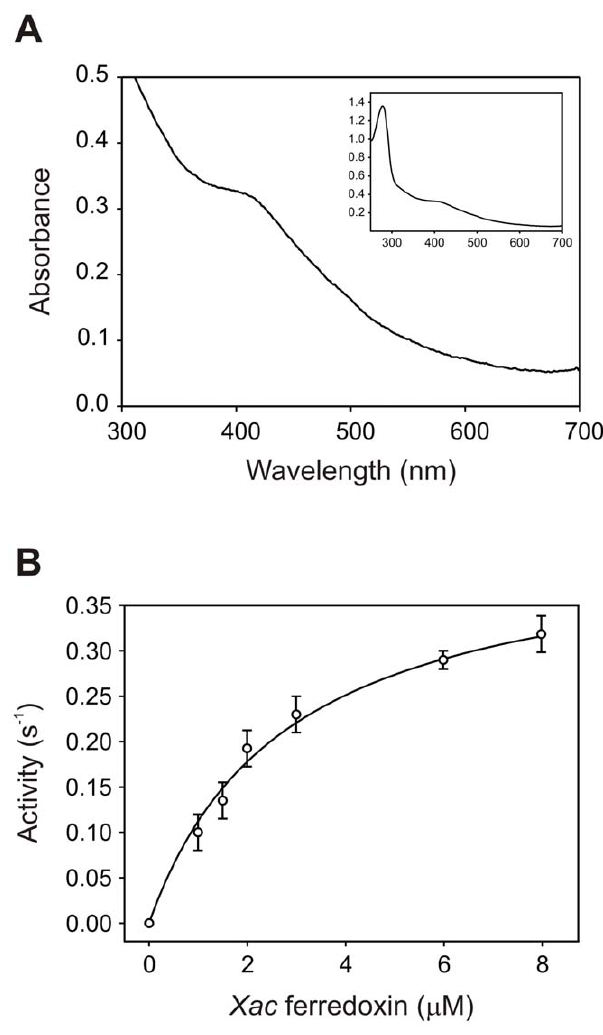
Figure 7. Characterization of ferredoxin XAC1762. (A) UV-visible spectrumdisplayedbyferredoxinXAC1762. (B) Kineticsofthe cytochrome c reductase reaction of Xac -FNR with ferredoxin XAC1762 as substrate.